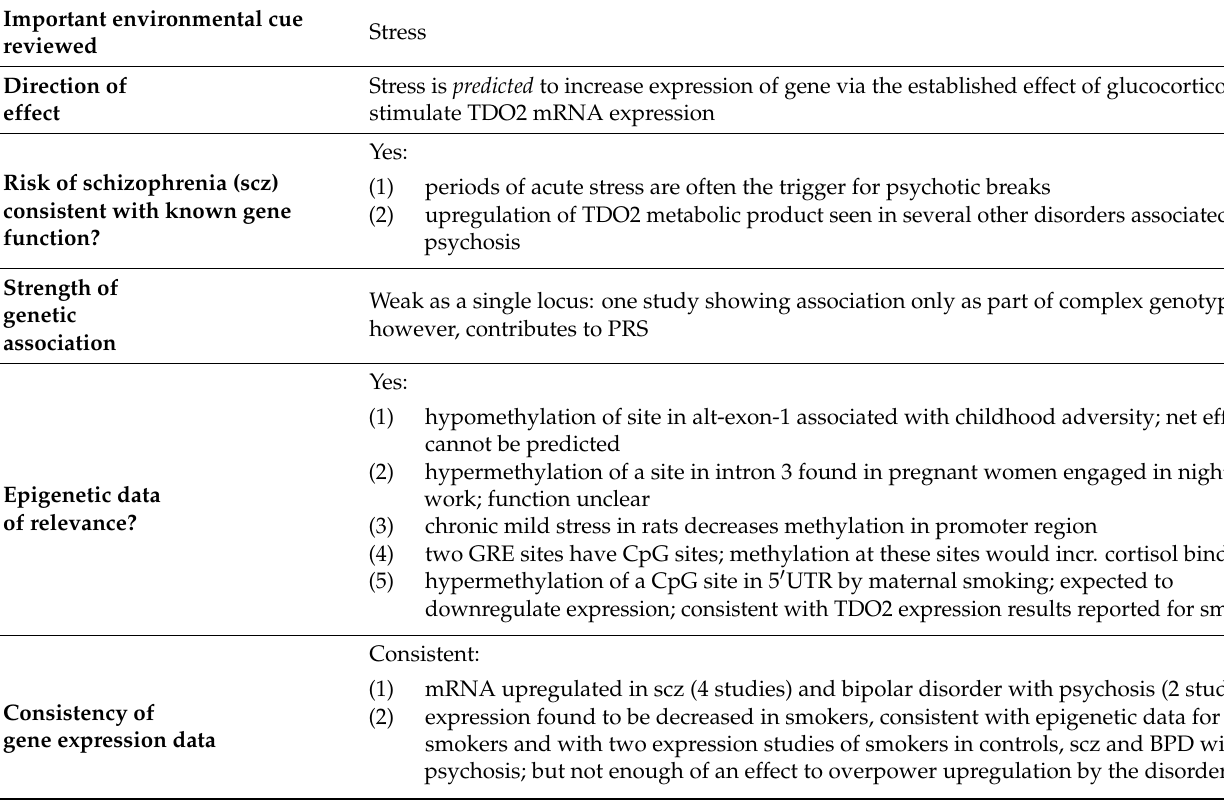
Table 3. Summary of major points for the gene